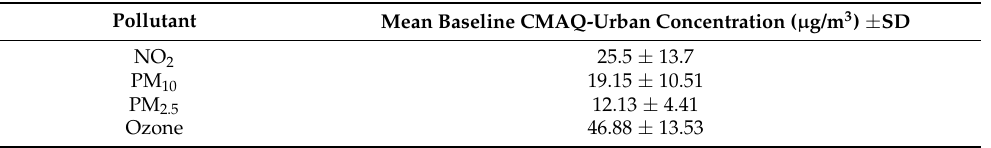
Table 2. Baseline CMAQ-urban modelled pollutant concentrations linked to ELSA respondents included in analysis of dementia